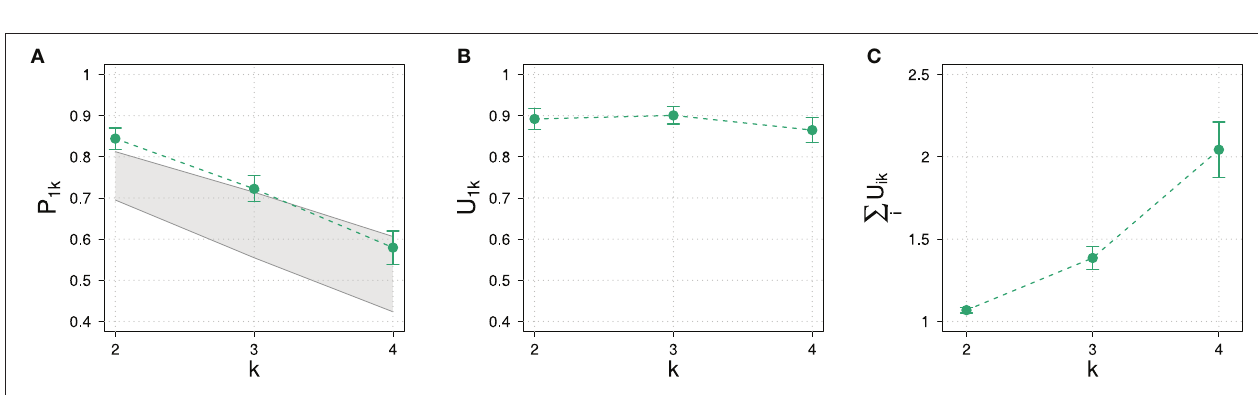
FIGURE 7 | (A) Normalized and (B) unnormalized slider values for the exhaustive state i = 1 as well as (C) average sums of raw slider values in Experiment